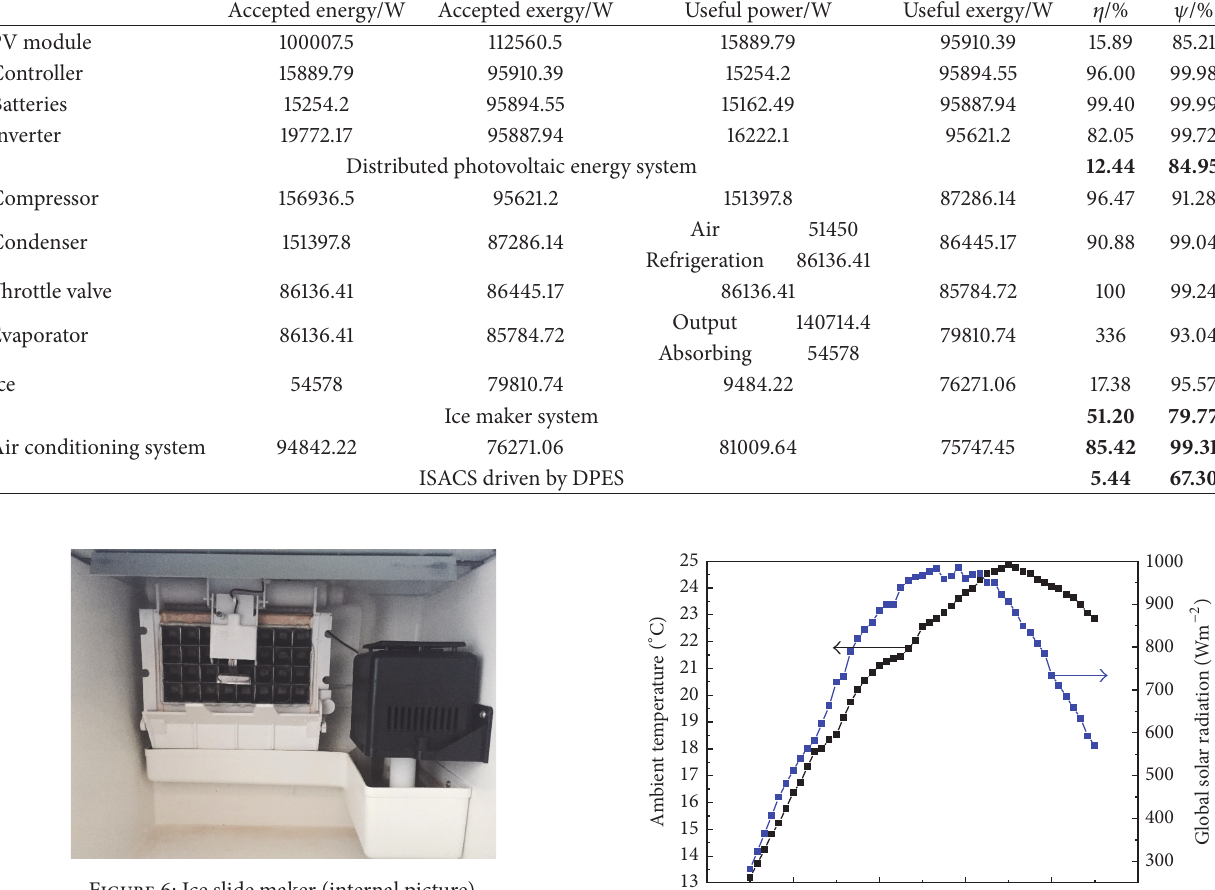
Figure 6: Ice slide maker (internal picture).